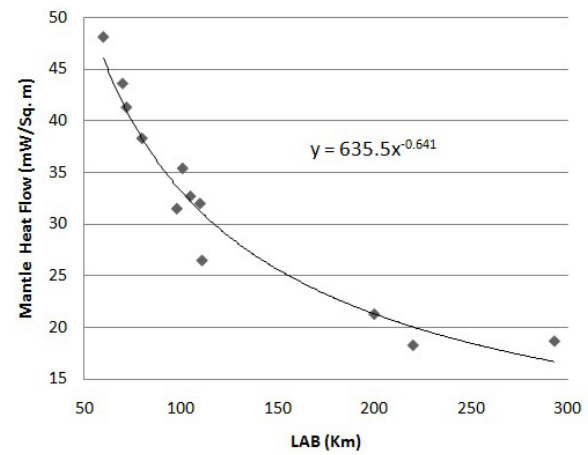
Fig. 5. Relationship between mantle heat flow and the depth to the lithosphere boundary (LAB),for different geotectonic units studied in the present